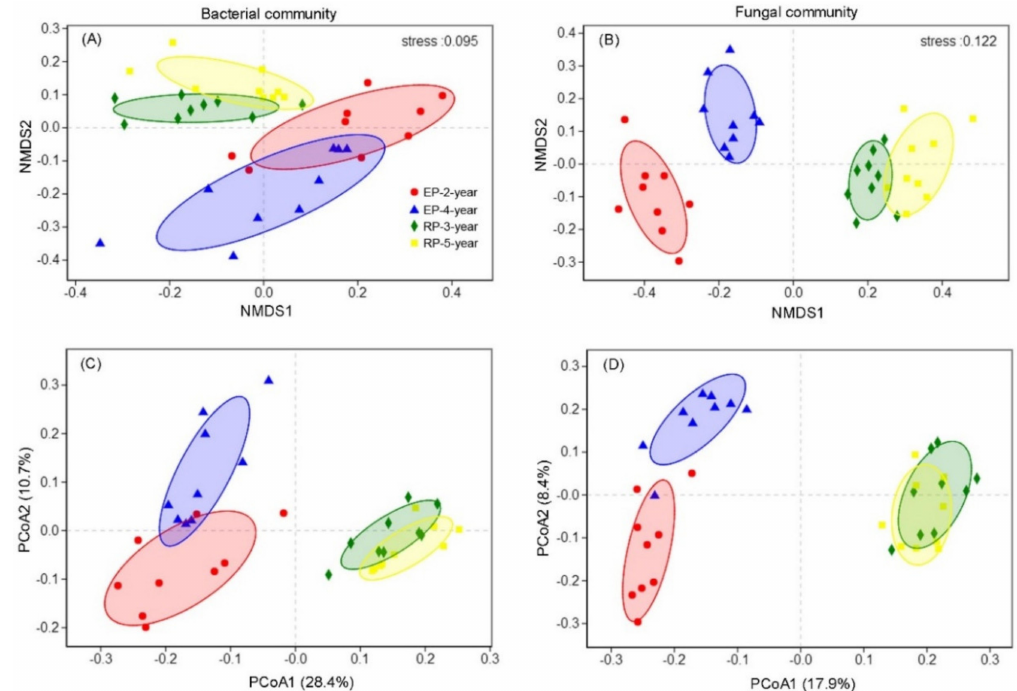
Figure 3. Non-metric multidimensional scaling (NMDS) ordination and principal coordinates analysis (PCoA) showing the structure di ff erences of soil bacterial (AC) and fungal (BD) communities among the four Rubber and Eucalypt plantations (EP-2-year, EP-4-year, RP-3-year, RP-5-year). The NMDS analysis was performed based on Bray-Curtis dissimilarity matrix, and the PCoA was conducted with the Unweighted Unifrac dissimilarity